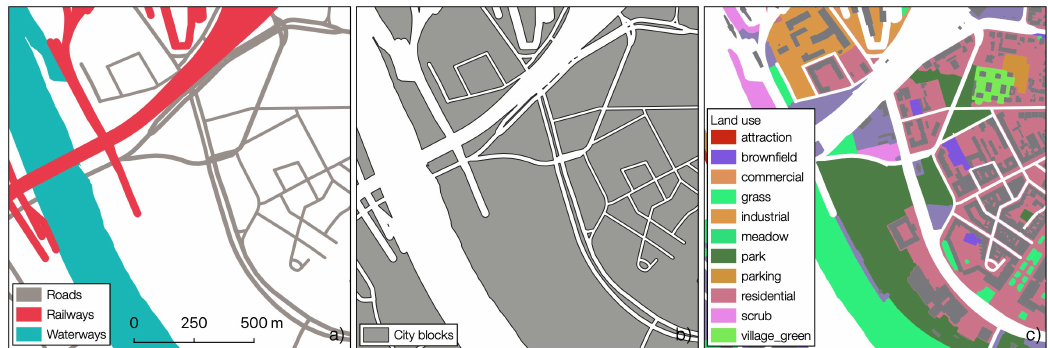
Figure 3. Subset of the study area showing the generated land use polygons. ( a ) Traffic network from OSM, ( b ) City blocks created from the traffic network and ( c ) Sub-blocks derived from land use features and buildings mapped in OSM. Table 1. OSM tags and geometry types which were considered for the city block generation.